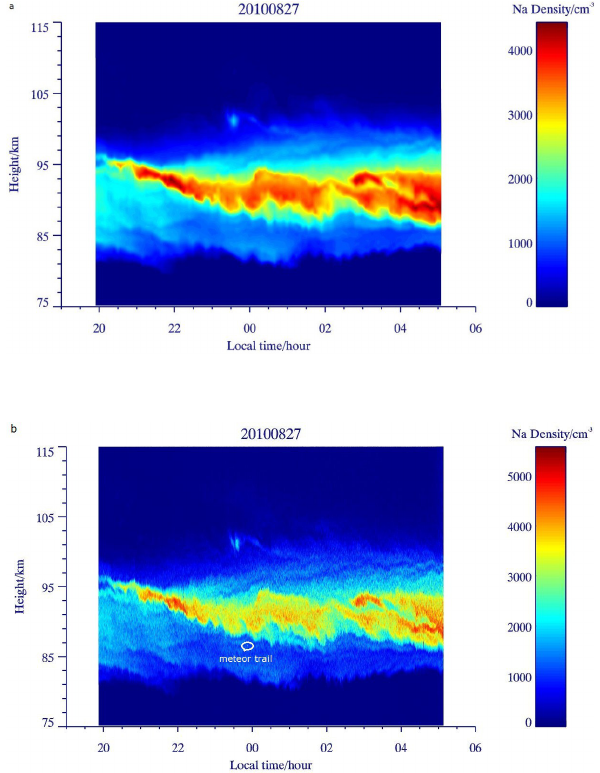
Fig. 3. Na density variations with time and height observed at dif- ferent time resolutions on the night of 27 August 2010: (a) 5min; (b) 1.5s.